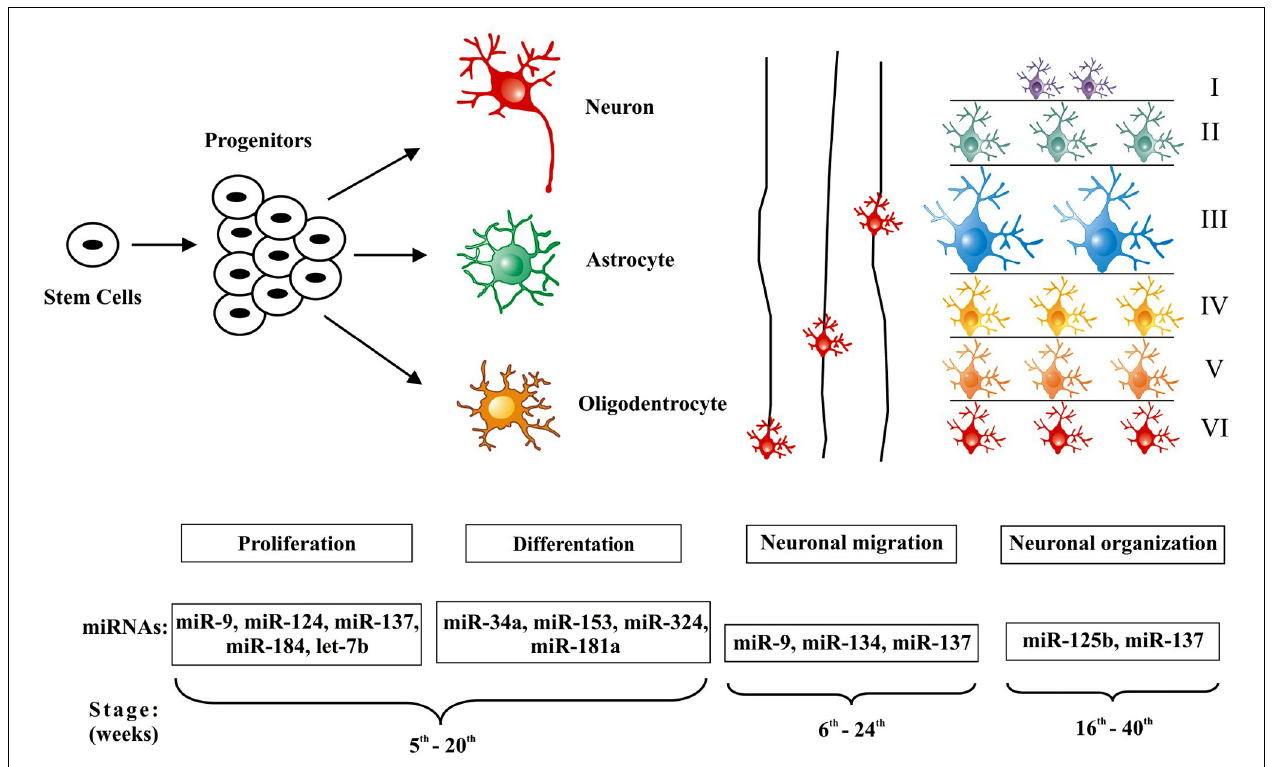
miR-124, miR-137, miR-184, let-7b and miR-34a, miR-153, miR-324, miR- 181a. Successive waves of neurons migrate (6th–24th weeks of ges- tation) from the ventricular regions, along radial glial cells, toward the more external areas of the cortex, these processes are regulated by miR-9, miR-134, and miR-137. Finally, the organization of cortical layers (16th–40th, weeks of gestation) is regulated at this stage through miR-137 and